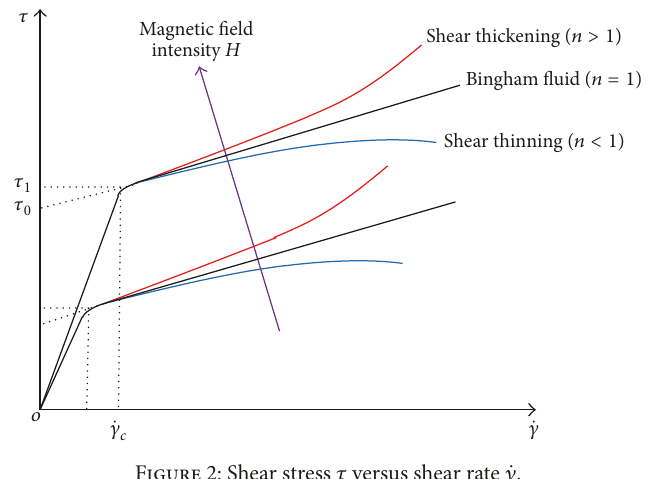
Figure 2: Shear stress 𝜏 versus shear rate ̇𝛾 .